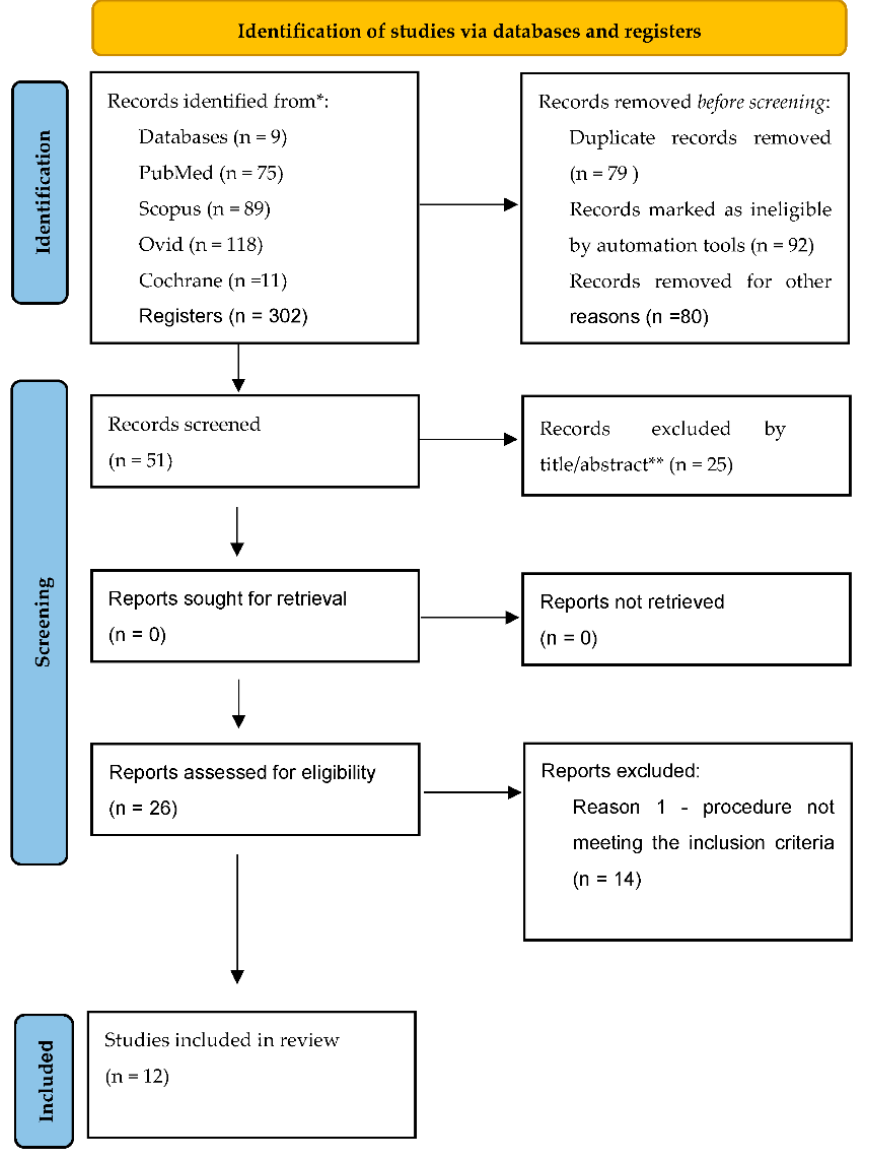
Figure 1. PRISMA flow diagram. Table 2. Instruments used and